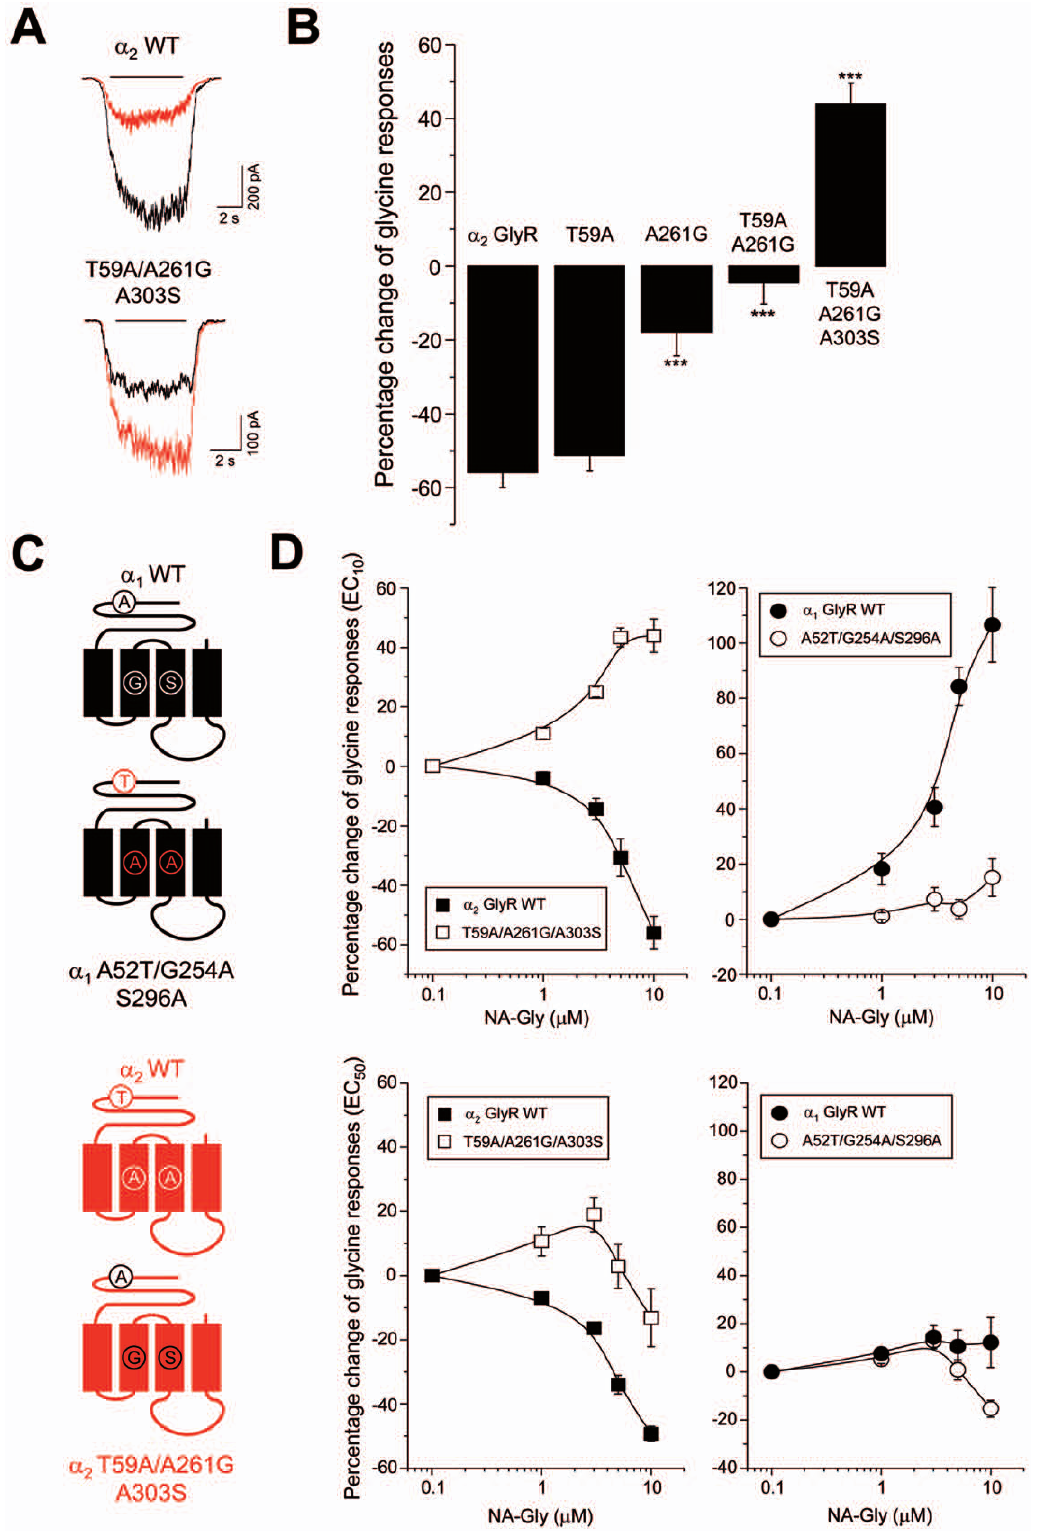
Figure 5. Selective extracellular loop 2 and TM domain mutations in a 2 GlyRs convert NA-Gly into an allosteric potentiator. ( A ) Examples of glycine-activated current traces from wild-type a 1 and mutant a 2 T59A/A261G/A303S GlyRs in the presence of NA-Gly (in red) ( B ) Summary of the effects of NA-Gly after simultaneous extracellular loop 2 and TM reverse mutations on a 2 GlyRs (*** P , 0.001, vs a 2 GlyRs) ( C ) Schematic diagrams of the triple mutated a 1 and a 2 GlyRs ( D ) Sensitivity of the normalized glycine-activated currents elicited in wild-type and triple mutated GlyRs to different concentrations of NA-Gly. Note that three simultaneous reverse mutations in a 2 GlyR converted NA-Gly into an allosteric potentiator, whereas the homologous substitutions within a 1 GlyR still did not produce a significant inhibition. doi:10.1371/journal.pone.0023886.g005 PLoS ONE |